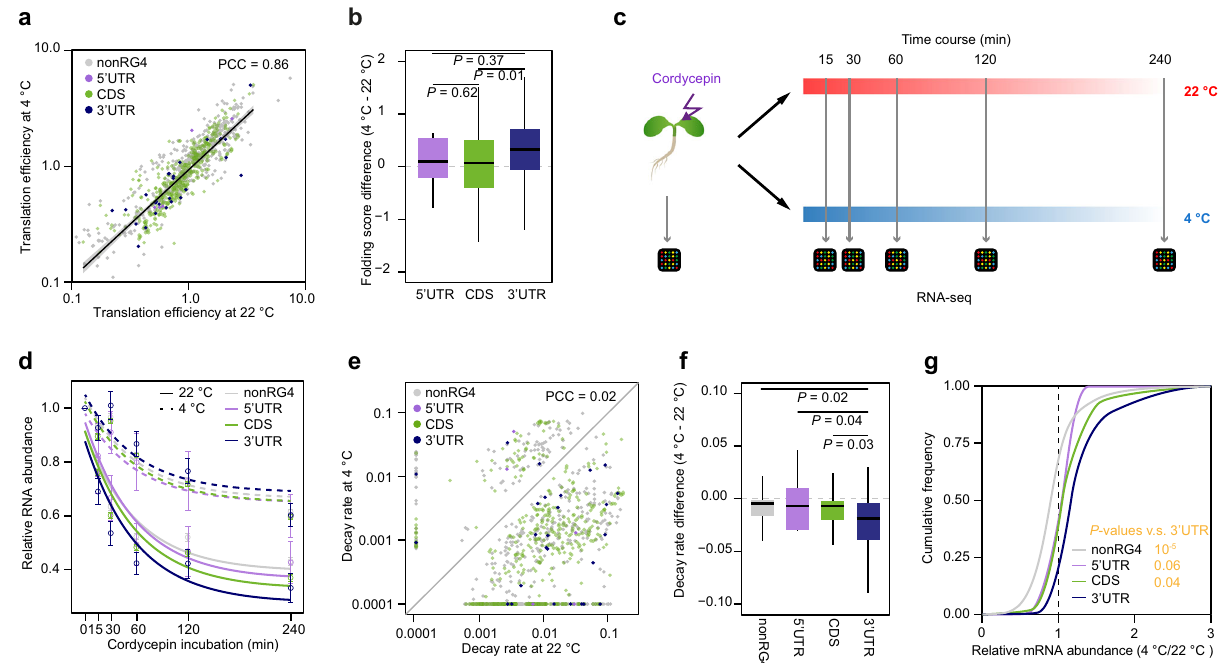
Fig. 3 | Cold-responsive RNA G-quadruplex in 3 ′ -UTR represses mRNA decay. a Comparisonoftranslationef fi ciency(TE)at22°Cand4°C,fortranscriptswithout RG4 (nonRG4), with RG4 in 5 ′ -UTR, with RG4 in CDS, and with RG4 in 3 ′ -UTR. The number of transcripts, n =465, 6, 531, 36, for nonRG4, 5 ′ -UTR, CDS and 3 ′ -UTR respectively. TE was calculated based on three independent biological replicates. b Comparison of folding score differences (4 – 22°C) between RG4 located in dif- ferent genic regions. The number of RG4 sites, n =9, 1421, 57 for 5 ′ -UTR, CDS, and 3 ′ -UTR, respectively; P values by two-sided Student ’ s t test. c Schematic of deter- mining RNA stability in Arabidopsis at 22°C and 4°C, by transcriptional arrest